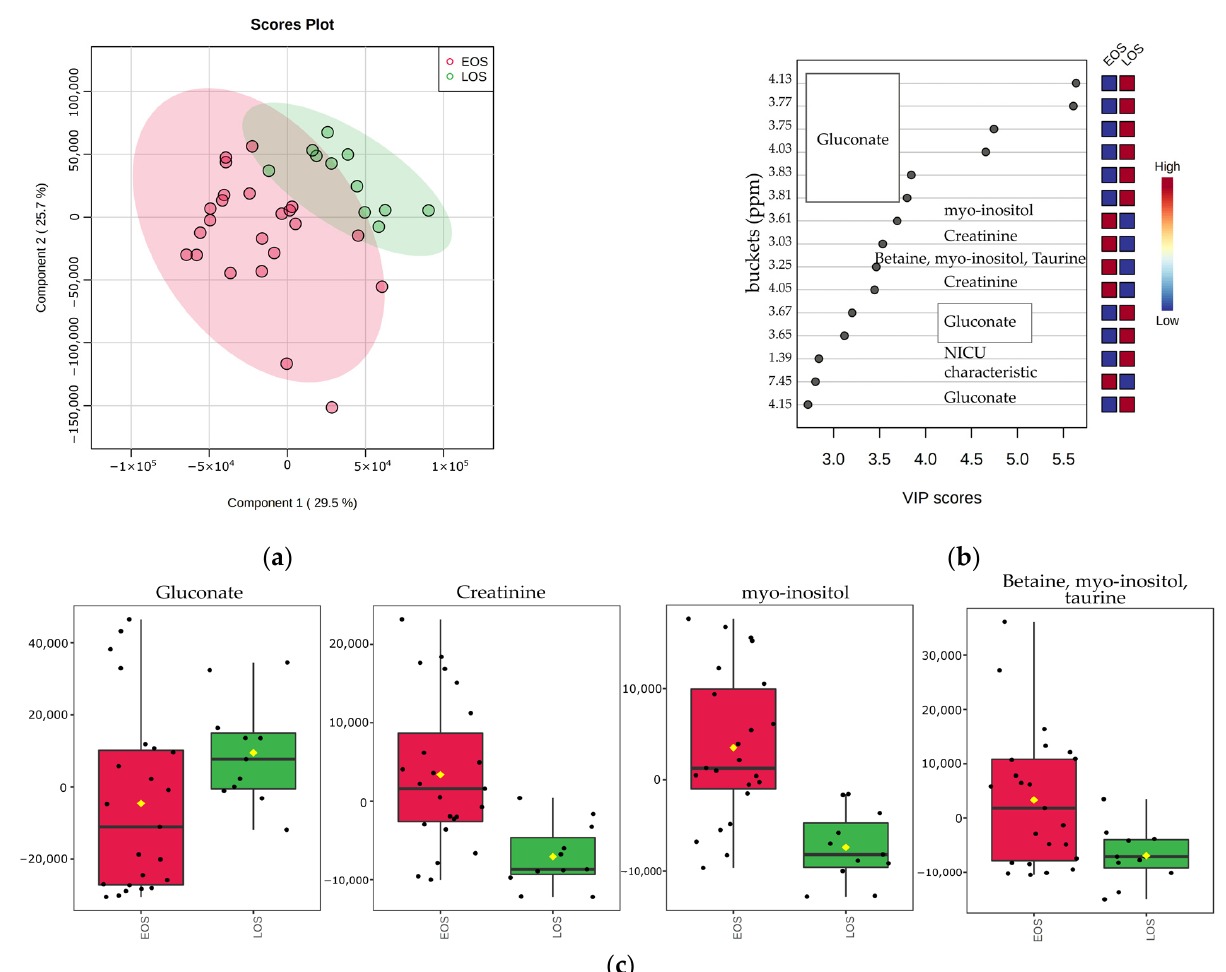
Figure 7. Multivariate analysis of NMR data belonging to urine samples of neonates diagnosed with EOS (red circles) and neonates with LOS (green circles). ( a ) PLS-DA scores plot of EOS and LOS samples. ( b ) VIP scores and metabolites related to buckets with different concentration among the two groups. ( c ) Box plots of normalized concentration for the discriminant metabolites.